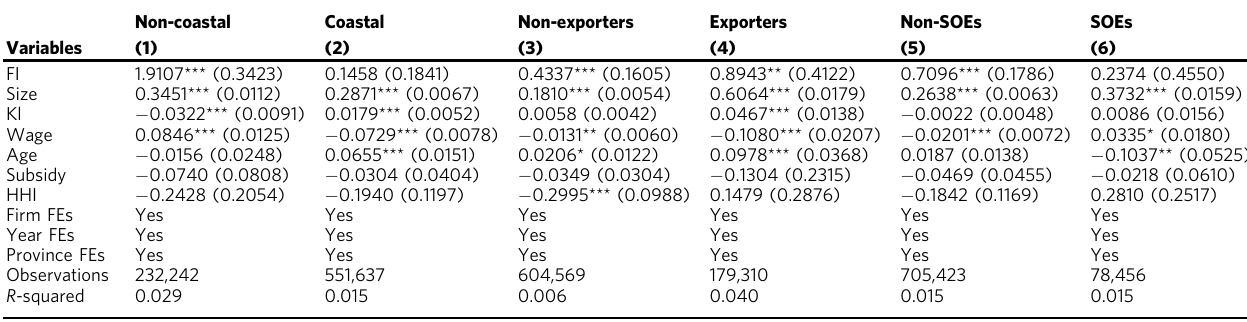
Table 6 Additional results of heterogeneous impact